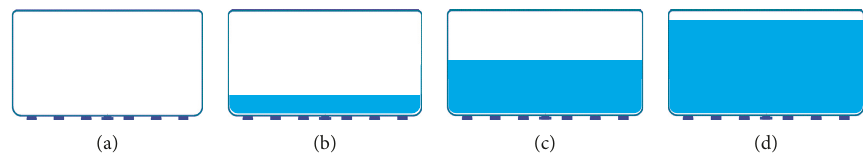
Figure 2: Loading conditions for considering different filling ratios of the LNG fuel tank: (a) empty state, (b) 15%, (c) 50%, and (d) 90%.